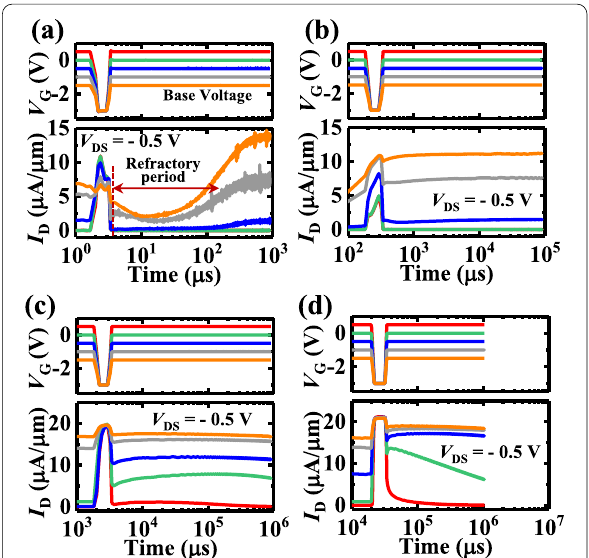
Fig. 3 Base voltage varies from 0.5 to -1.5 V. The widths of V G pulses in a – d are 1 μs, 100 μs, 1 ms, and 10 ms, respectively